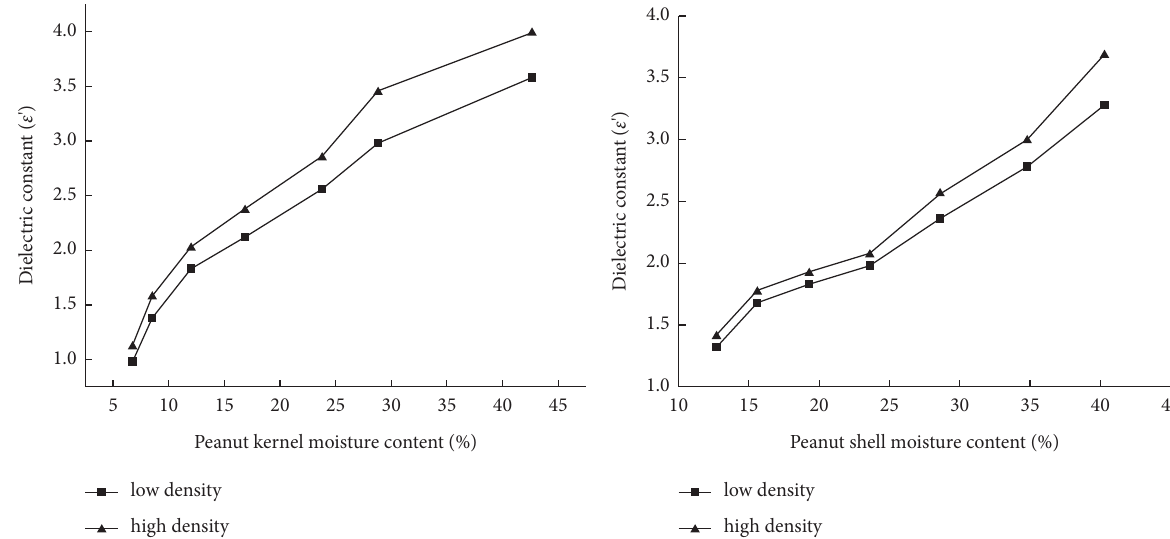
Figure 8: Te efect of moisture content on the relative dielectric constants of peanut shells and kernels at diferent bulk densities.